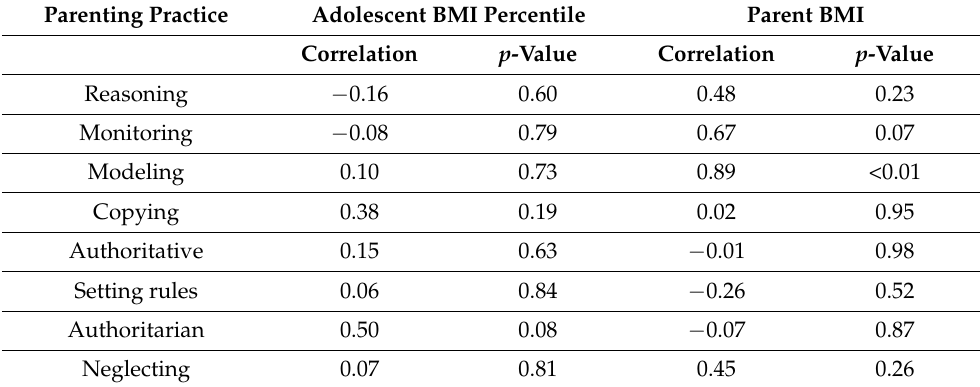
Table 5. Correlation between parenting practices and obesity. Parenting Practice Adolescent BMI